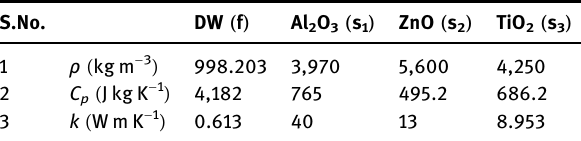
Figure 1: Graphical illustration of the transport phenomenon.